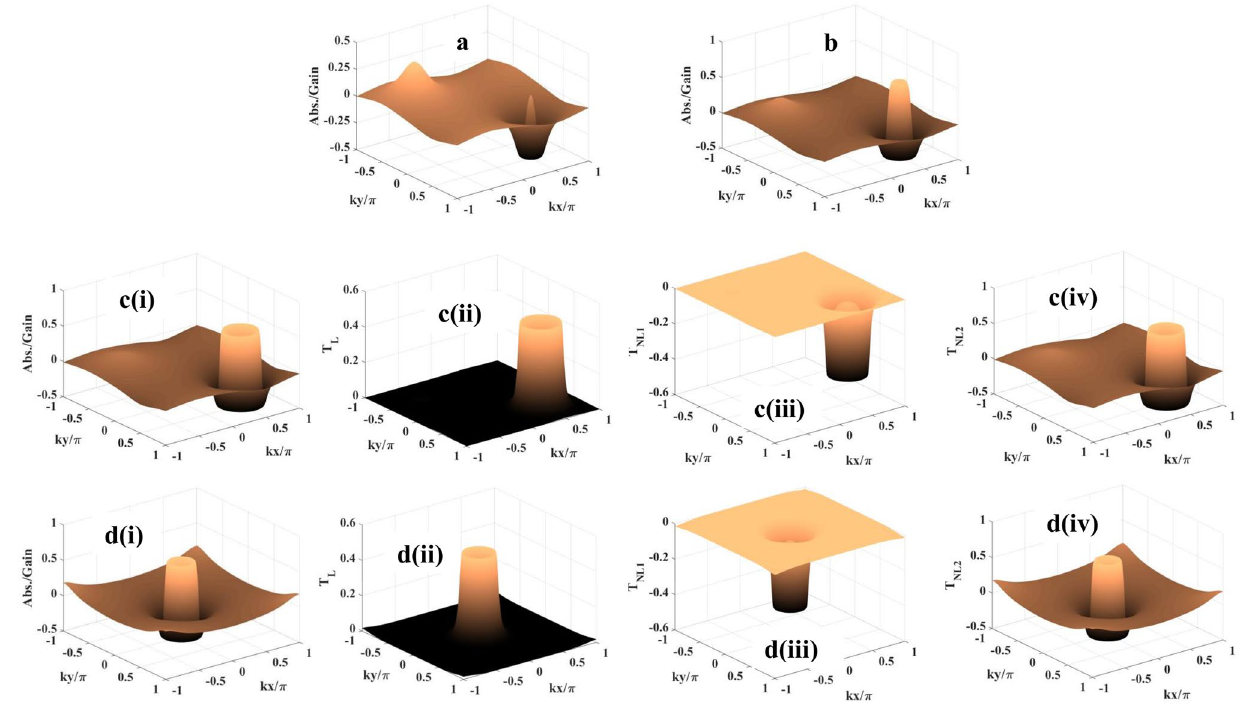
Figure 3. Probe absorption-gain spectra: ( a ) R n 0 = 1 meV, φ 1 = φ 2 = 0 ; ( b ) R n 0 = 2 meV, φ 1 = φ 2 = 0 ; c(i) . R n 0 = 4 meV, φ 1 = φ 2 = 0 ; d(i) R n 0 = 3 meV, φ 1 = φ 2 = π/ 2 . c(ii) [d(ii)] , c(iii) [d(iii)] , and c(iv) [d(iv)] show the respective contribution of T L , T NL 1 , and T NL 2 to the formation of spectrum shown in Fig. c(i) [d(i)] . Parameters: φ = π/ 2, R na = R c = 10 meV, R m = 0.05 meV, (cid:31) p = 30 meV, (cid:31) c = − 10 meV, and (cid:31) m = 12